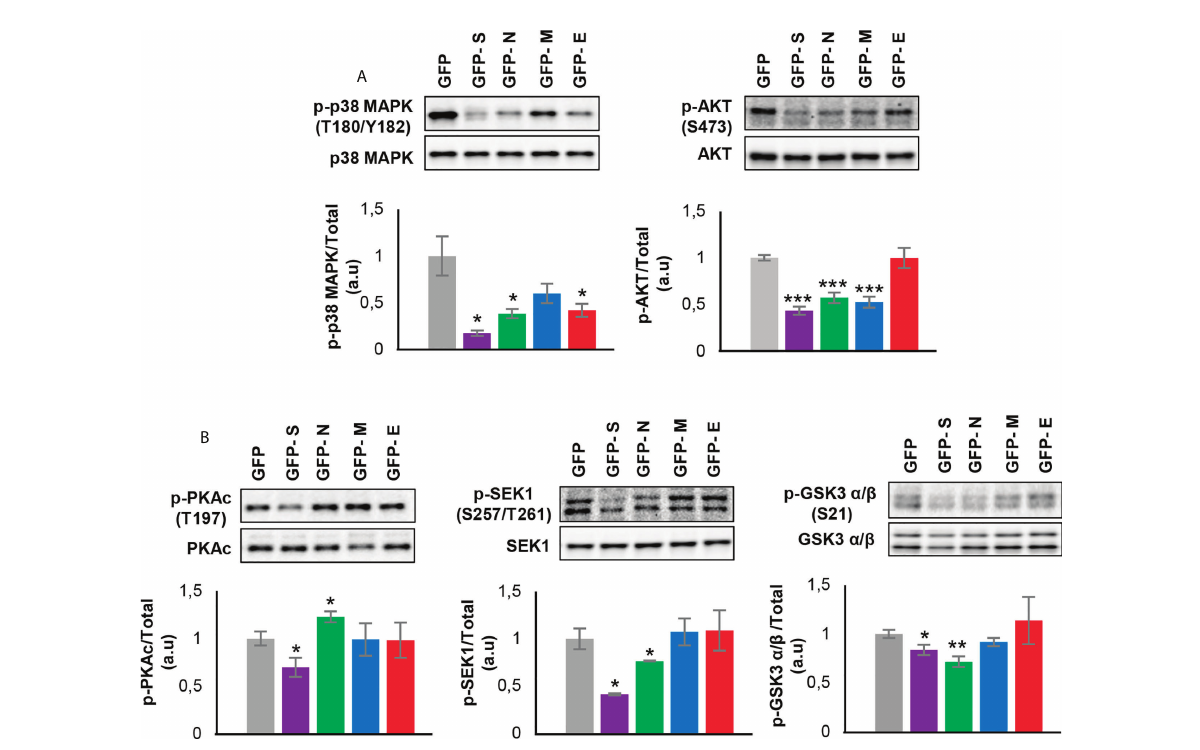
FIGURE 5 Levels and residue-speci fi c phosphorylation of (A) p38 MAPK, Akt and (B) PKA, SEK1 and GSK3 in GFP- SARS-CoV-2 structural protein expressing-OBC1 cells. Equal loading of the gels was assessed by stain-free digitalization. Panels show histograms of band densities. Data are presented as mean ± SEM from four independent biological replicates. *P < 0.05 vs. GFP; **P < 0.01 vs. GFP; *** P < 0.001 vs. GFP (a.u: arbitrary